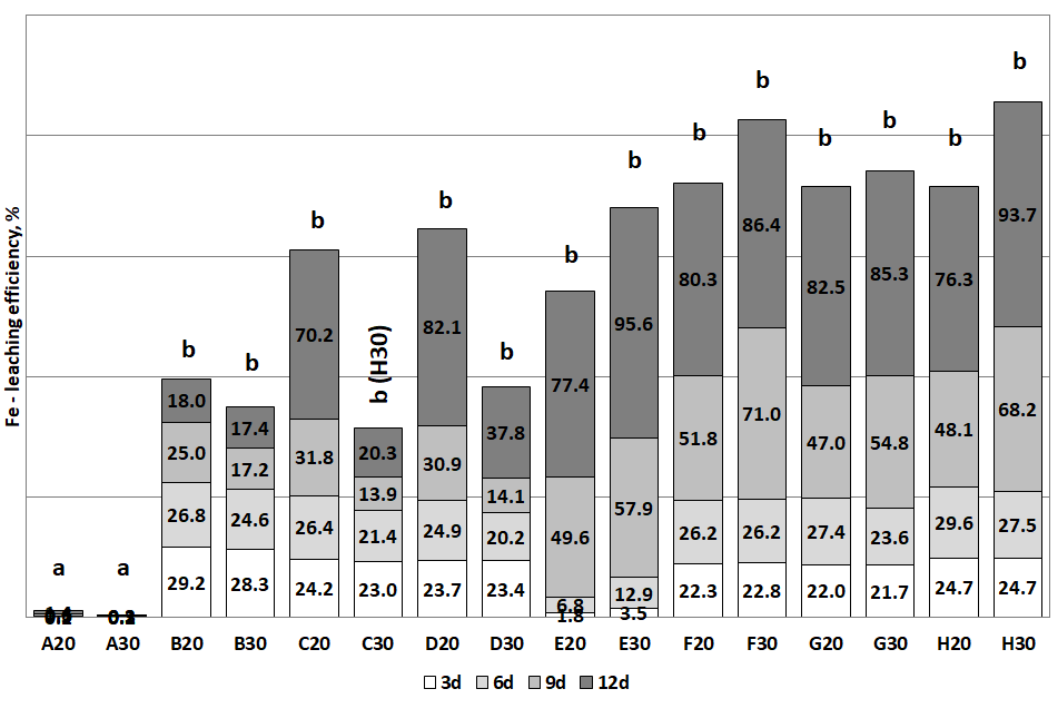
Figure 11. Bioleaching efficiency of Fe during the experiment (Statistical groups a and b ).